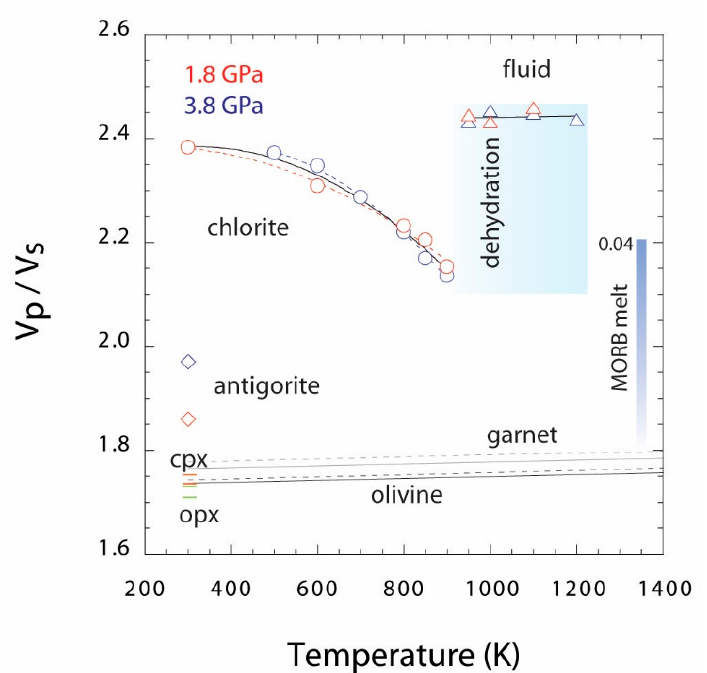
Figure 5. The Vp/Vs ratios of chlorite and dehydrating fluid at 1.8 and 3.8 GPa. The Vp/Vs of major mantle phases, olivine, garnet, clinopyroxene (cpx), orthopyroxene (opx), are shown for comparison [47]. Diamond symbols indicate antigorite [23] at 1.8 GPa (red) and 3.8 GPa (blue) at 300 K. The blue shaded line indicates the Vp/Vs of basaltic melt [18] for increasing melt fraction. The faded blue area corresponds to the dehydrating fluid. The red and blue dashed-lines are the second-order polynomial fits through data points.